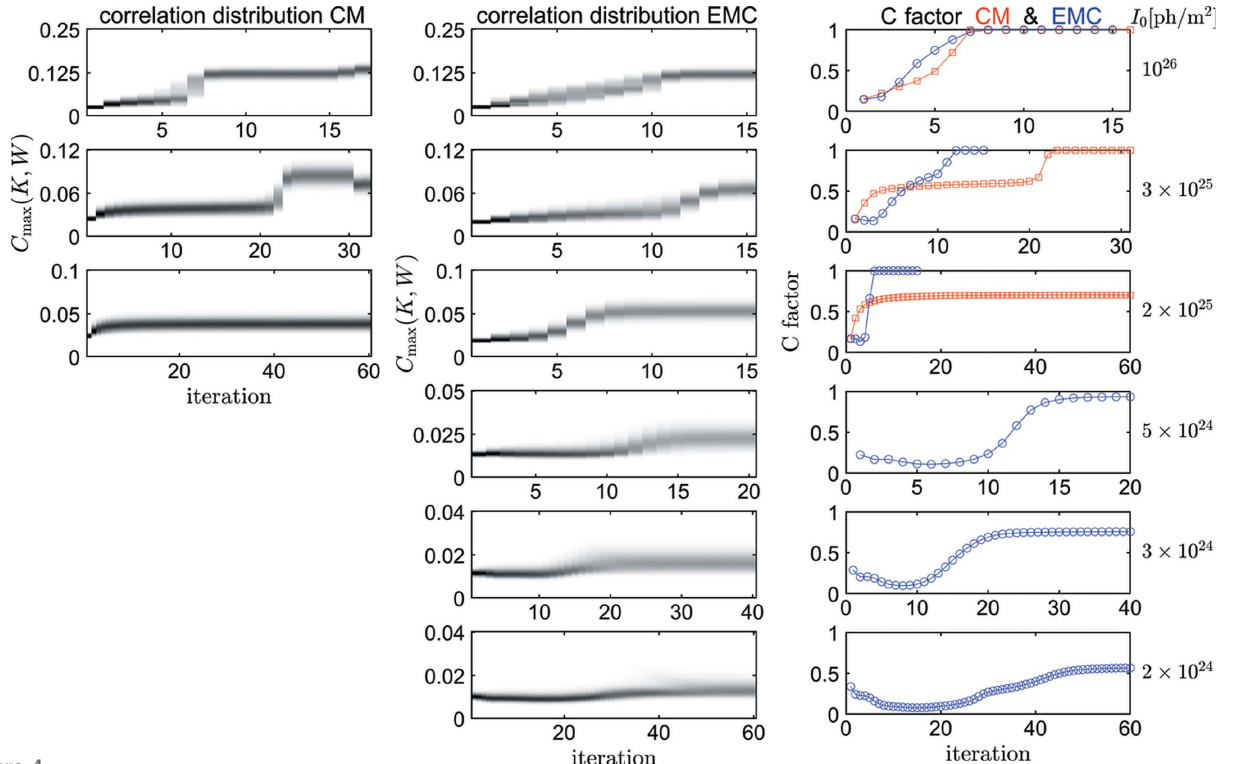
Figure 4 Development of the correlation distributions for the CM (left column) and EMC (middle column) methods at various incident XFEL fluences (indicated at the right-hand side of the figure). The grayscale is linear between zero (white) and the largest value (black). Right column: development of the C factor for the CM (red squares) and EMC (blue circles)